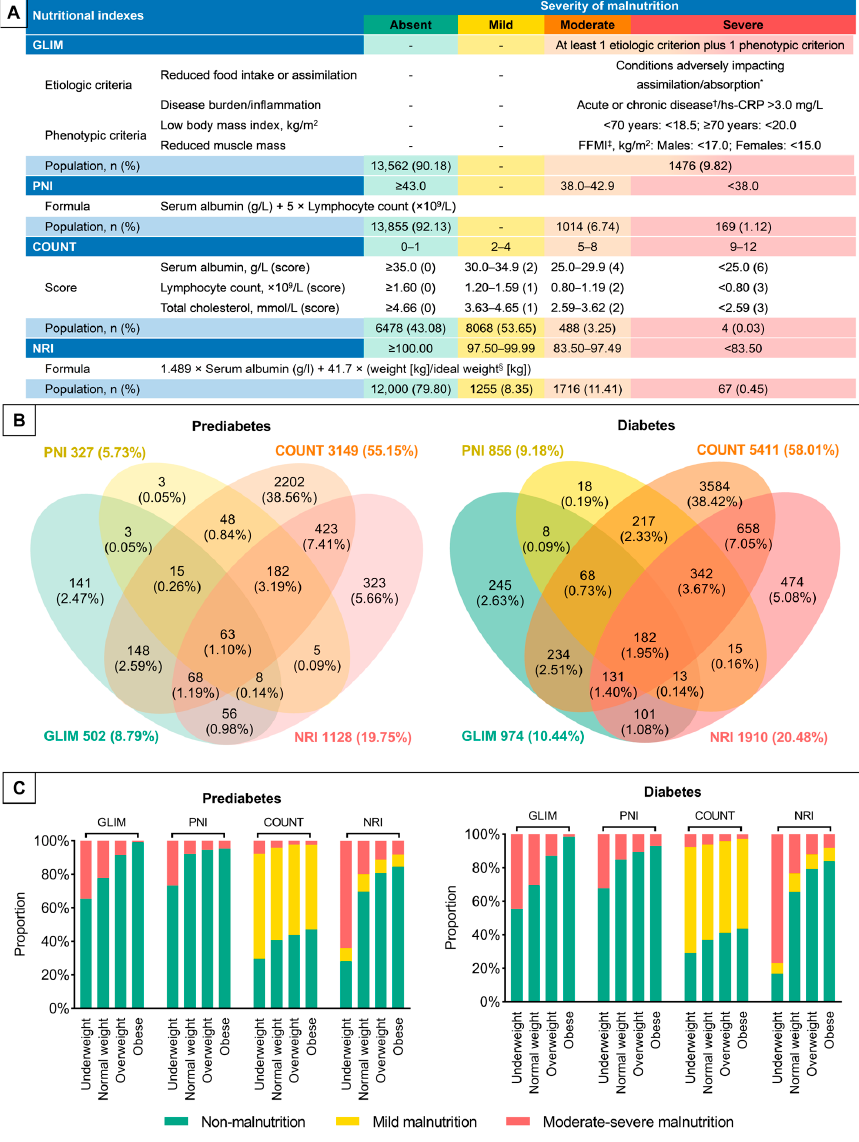
Figure 1. Prevalence of malnutrition. ( A ) Diagnosis and severity grading of malnutrition. ( B ) Number and percentage of malnourished patients according to different assessment tools. ( C ) Proportion of different nutritional statuses according to each assessment tool across body mass index categories (underweight (<18.5 kg/m 2 ), normal weight (18.5–22.9 kg/m 2 ), overweight (23.0–24.9 kg/m 2 ) and obese ( ≥ 25 kg/m 2 )). * e.g., esophagus cancer, inflammatory bowel disease, short bowel syndrome, or history of bariatric surgery; † e.g., sepsis, trauma, chronic obstructive pulmonary disease, or congestive heart failure; ‡ FFMI (kg/m 2 ) = weight (kg) × (1 − body fat (%)/100)/(height (m)) 2 ; § ideal weight, kg: men: height (cm) − 100 − ((height (cm) − 150)/4); women: height (cm) − 100 − ((height (cm) − 150)/2.5). COUNT, controlling nutritional status; FFMI, free-fat mass